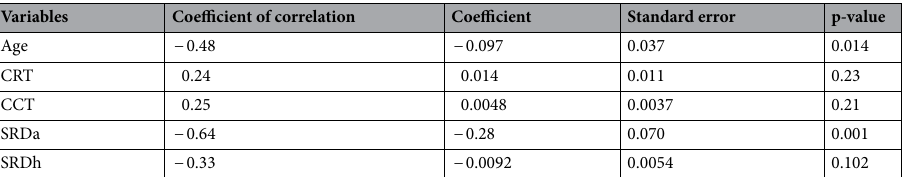
Table 3. Result of univariate analysis between the mean overall retinal sensitivity of white-on-white automated perimetry (W-RS) and optic coherence tomography parameters. CRT central retinal thickness, CCT central choroidal thickness, SRDa area sum of all observed SRD regions (foveal and extra-foveal), SRDh SRD height at the fovea.